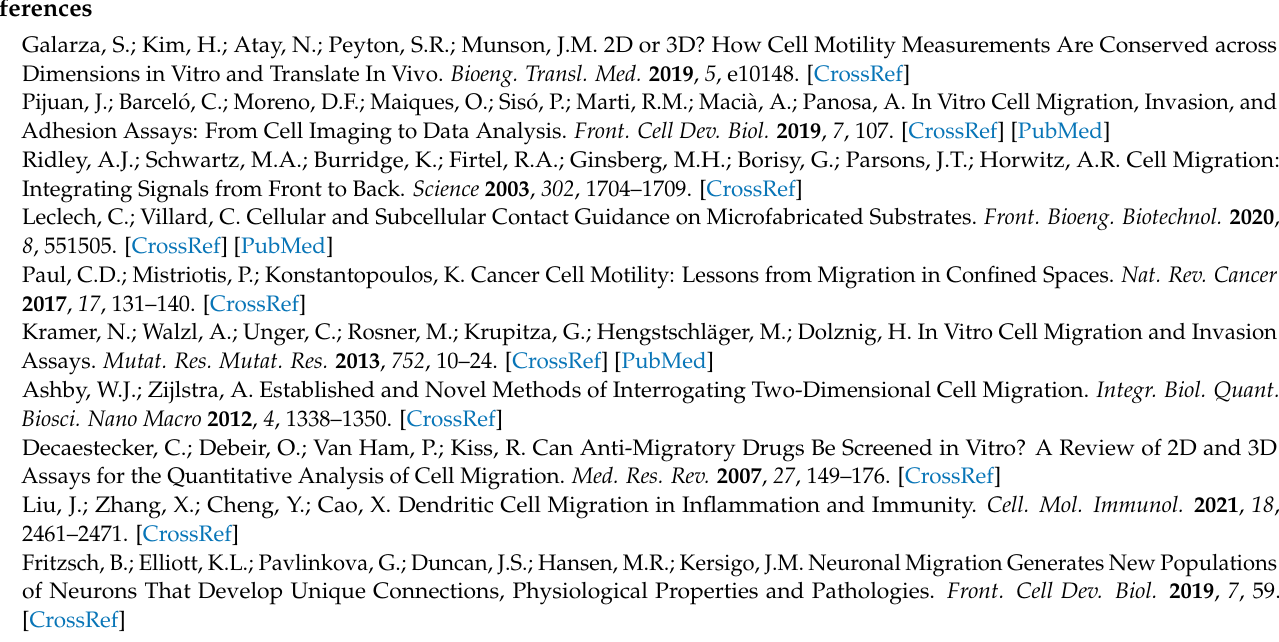
Figure S3: Evaluation of APTES functionalization efficacy. (a) Contact angle measurements to verify the functionalization and assess its stability after 24 hours; (b) Measurements of the average cell density (cells/cm 2 ) show the adhesion-enhancing properties of the APTES. Figure S4: An example of image where active count area (CA), in blue, and gap area (GA), in green, are drawn. The number 1 and 2 indicate two cells counted inside the gap area and count area,